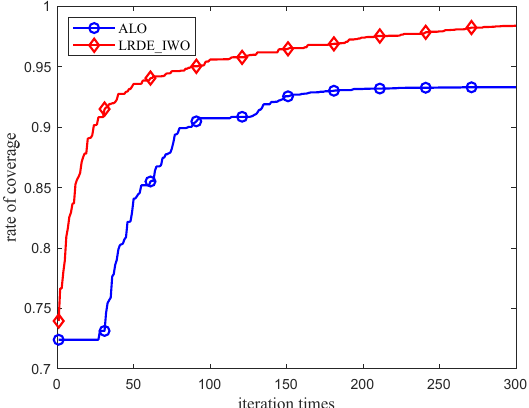
Figure 6. ALO and LRDE_IWO coverage optimization iterative curve.